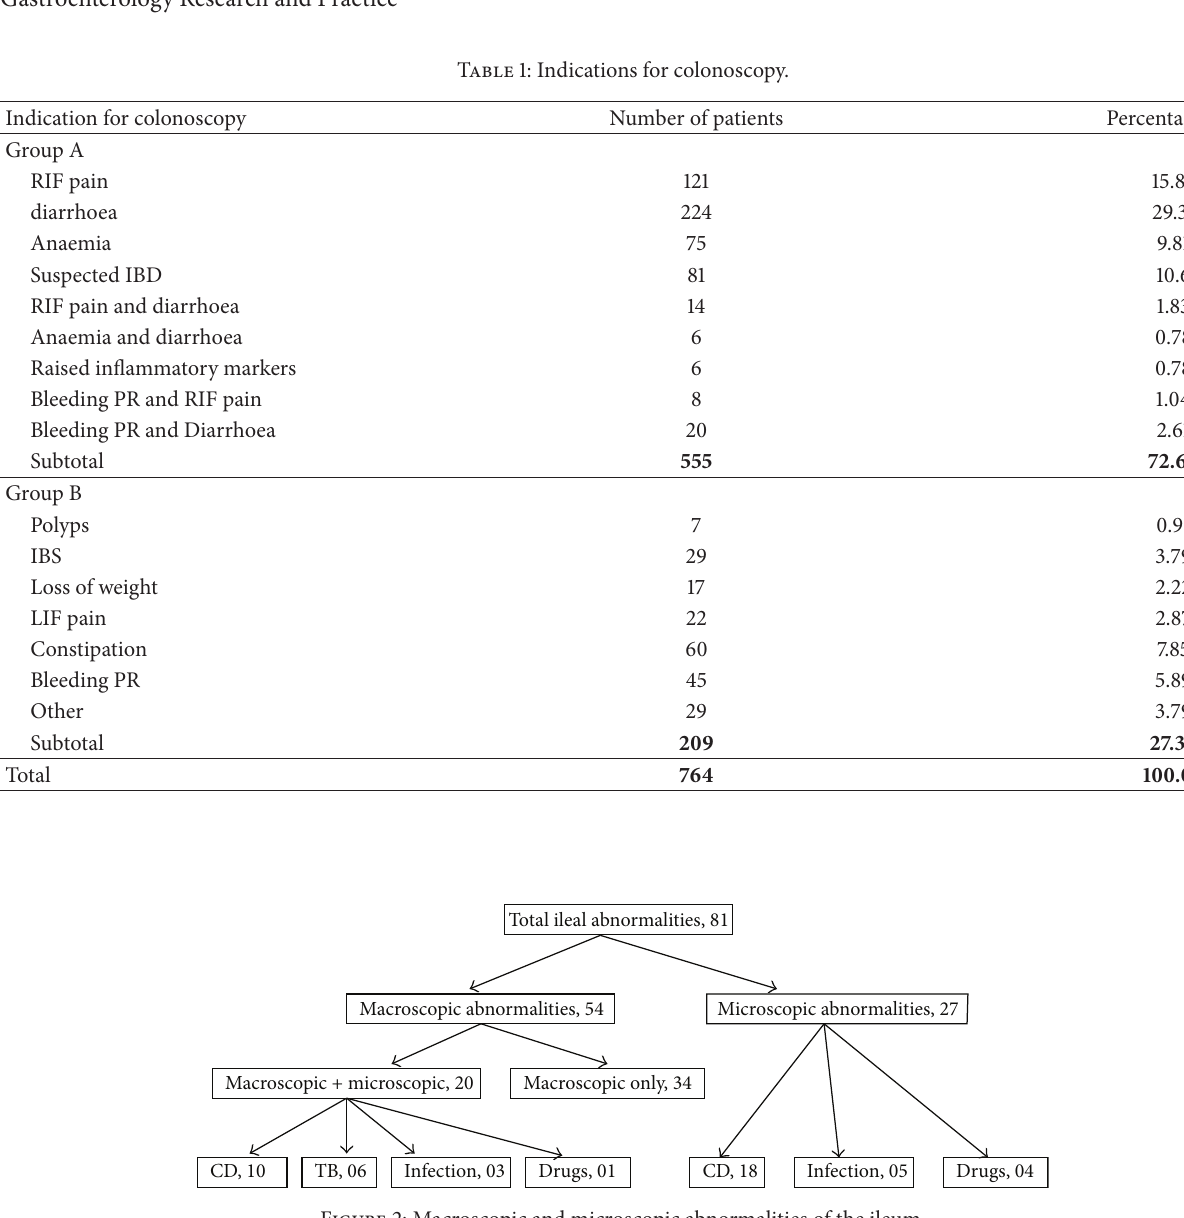
Figure 2: Macroscopic and microscopic abnormalities of the